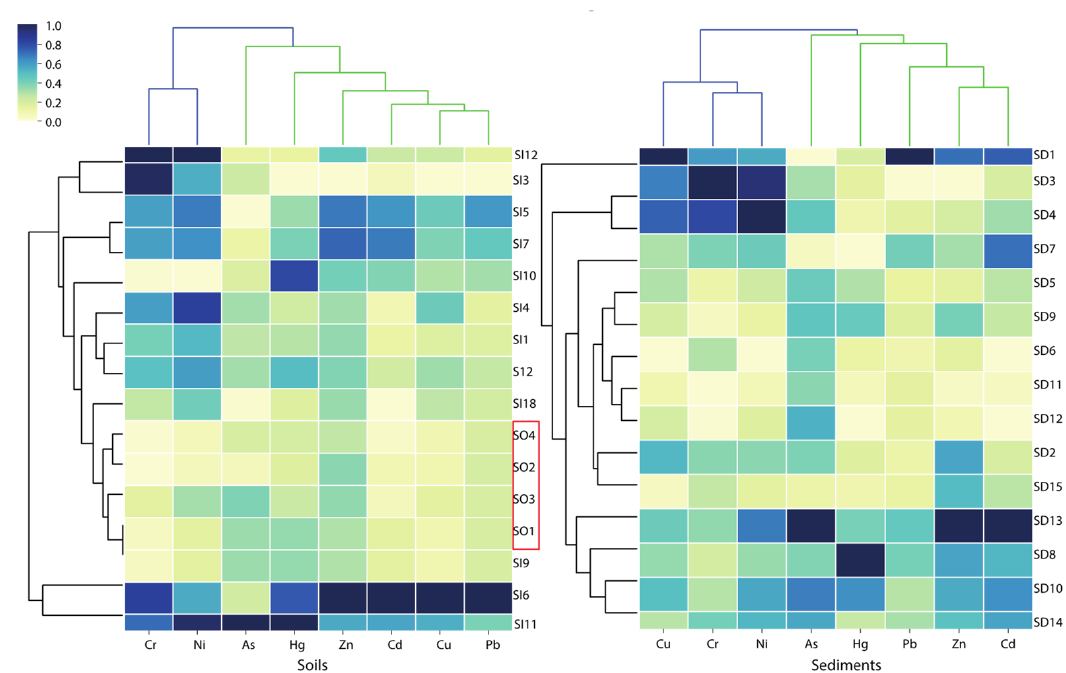
Figure 4. Pearson’s correlation analysis of PTE concentration in soils ( Left ) and sediments ( Right ) inside the mining area.